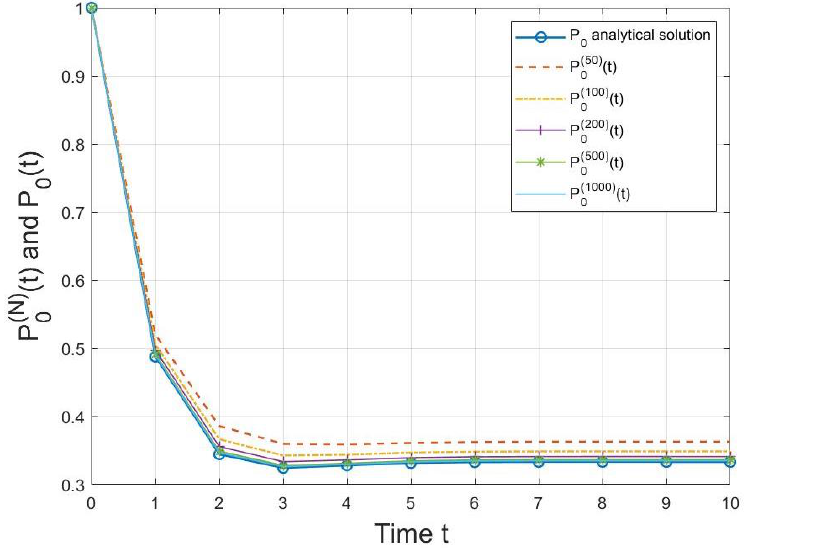
( N ) ( t ) obtained by the finite-differences method and the analytical Figure 4. Approximation solution ¯ P 0 solution P 0 ( t ) . Table 2. The error analysis of solutions derived by the finite-differences method in different